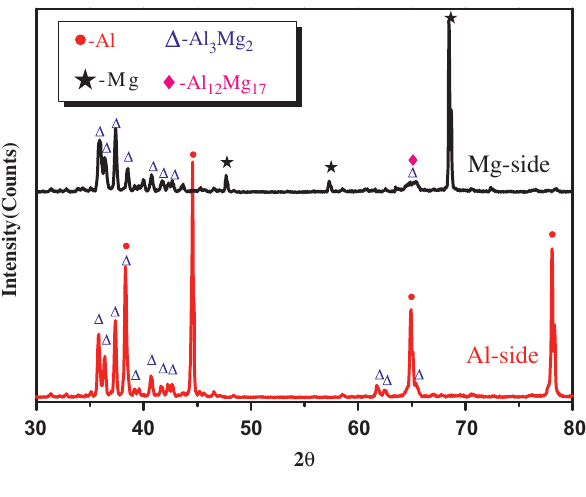
Figure 8: XRD patterns measured on cross-section of the fracture